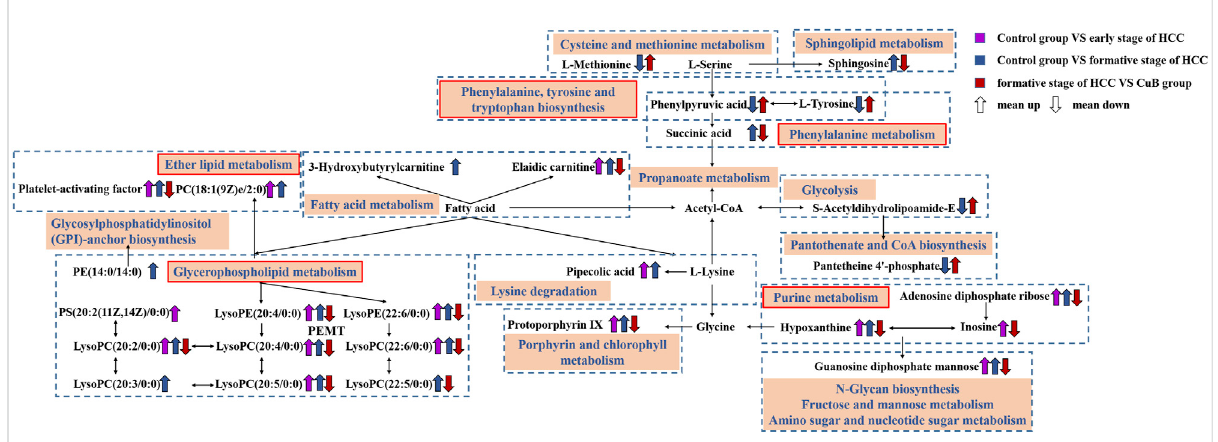
FIGURE 5 Metabolic network diagram. The rectangular boxes represent metabolic pathways. The purple arrows represent trends for Control group vs. early stage of HCC; The blue arrows represent trends for Control group vs. formative stage of HCC; The red arrows represent trends for formative stage of HCC vs. CuB